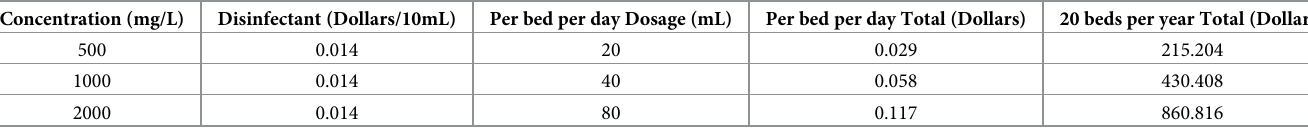
Table 2. Comparison of disinfection costs of 3 chlorine-containing disinfectants per bed per day. Concentration (mg/L) Disinfectant